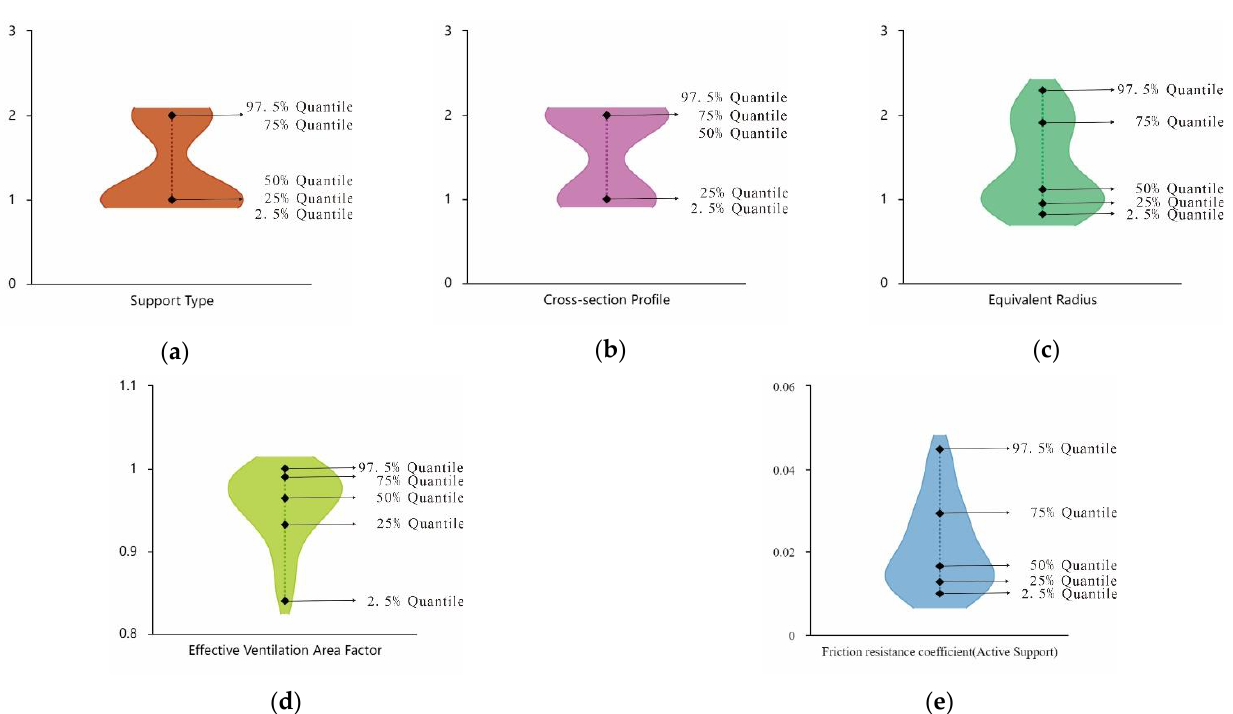
Figure 6. Violin plots showing the distribution of the passive support dataset. ( a ) Violin plot of the support-type data; ( b ) violin plot of the bracket size data; ( c ) violin plot of the roadway cross-sec- tional area data; ( d ) violin plot of the lane circumference data; ( e ) violin plot of the perimeter of the unsupported section data; ( f ) violin plot of the bracket longitudinal bore data; ( g ) violin plot of the cross-bore of bracket data; ( h ) violin plot of the friction resistance coefficient (passive support) data.